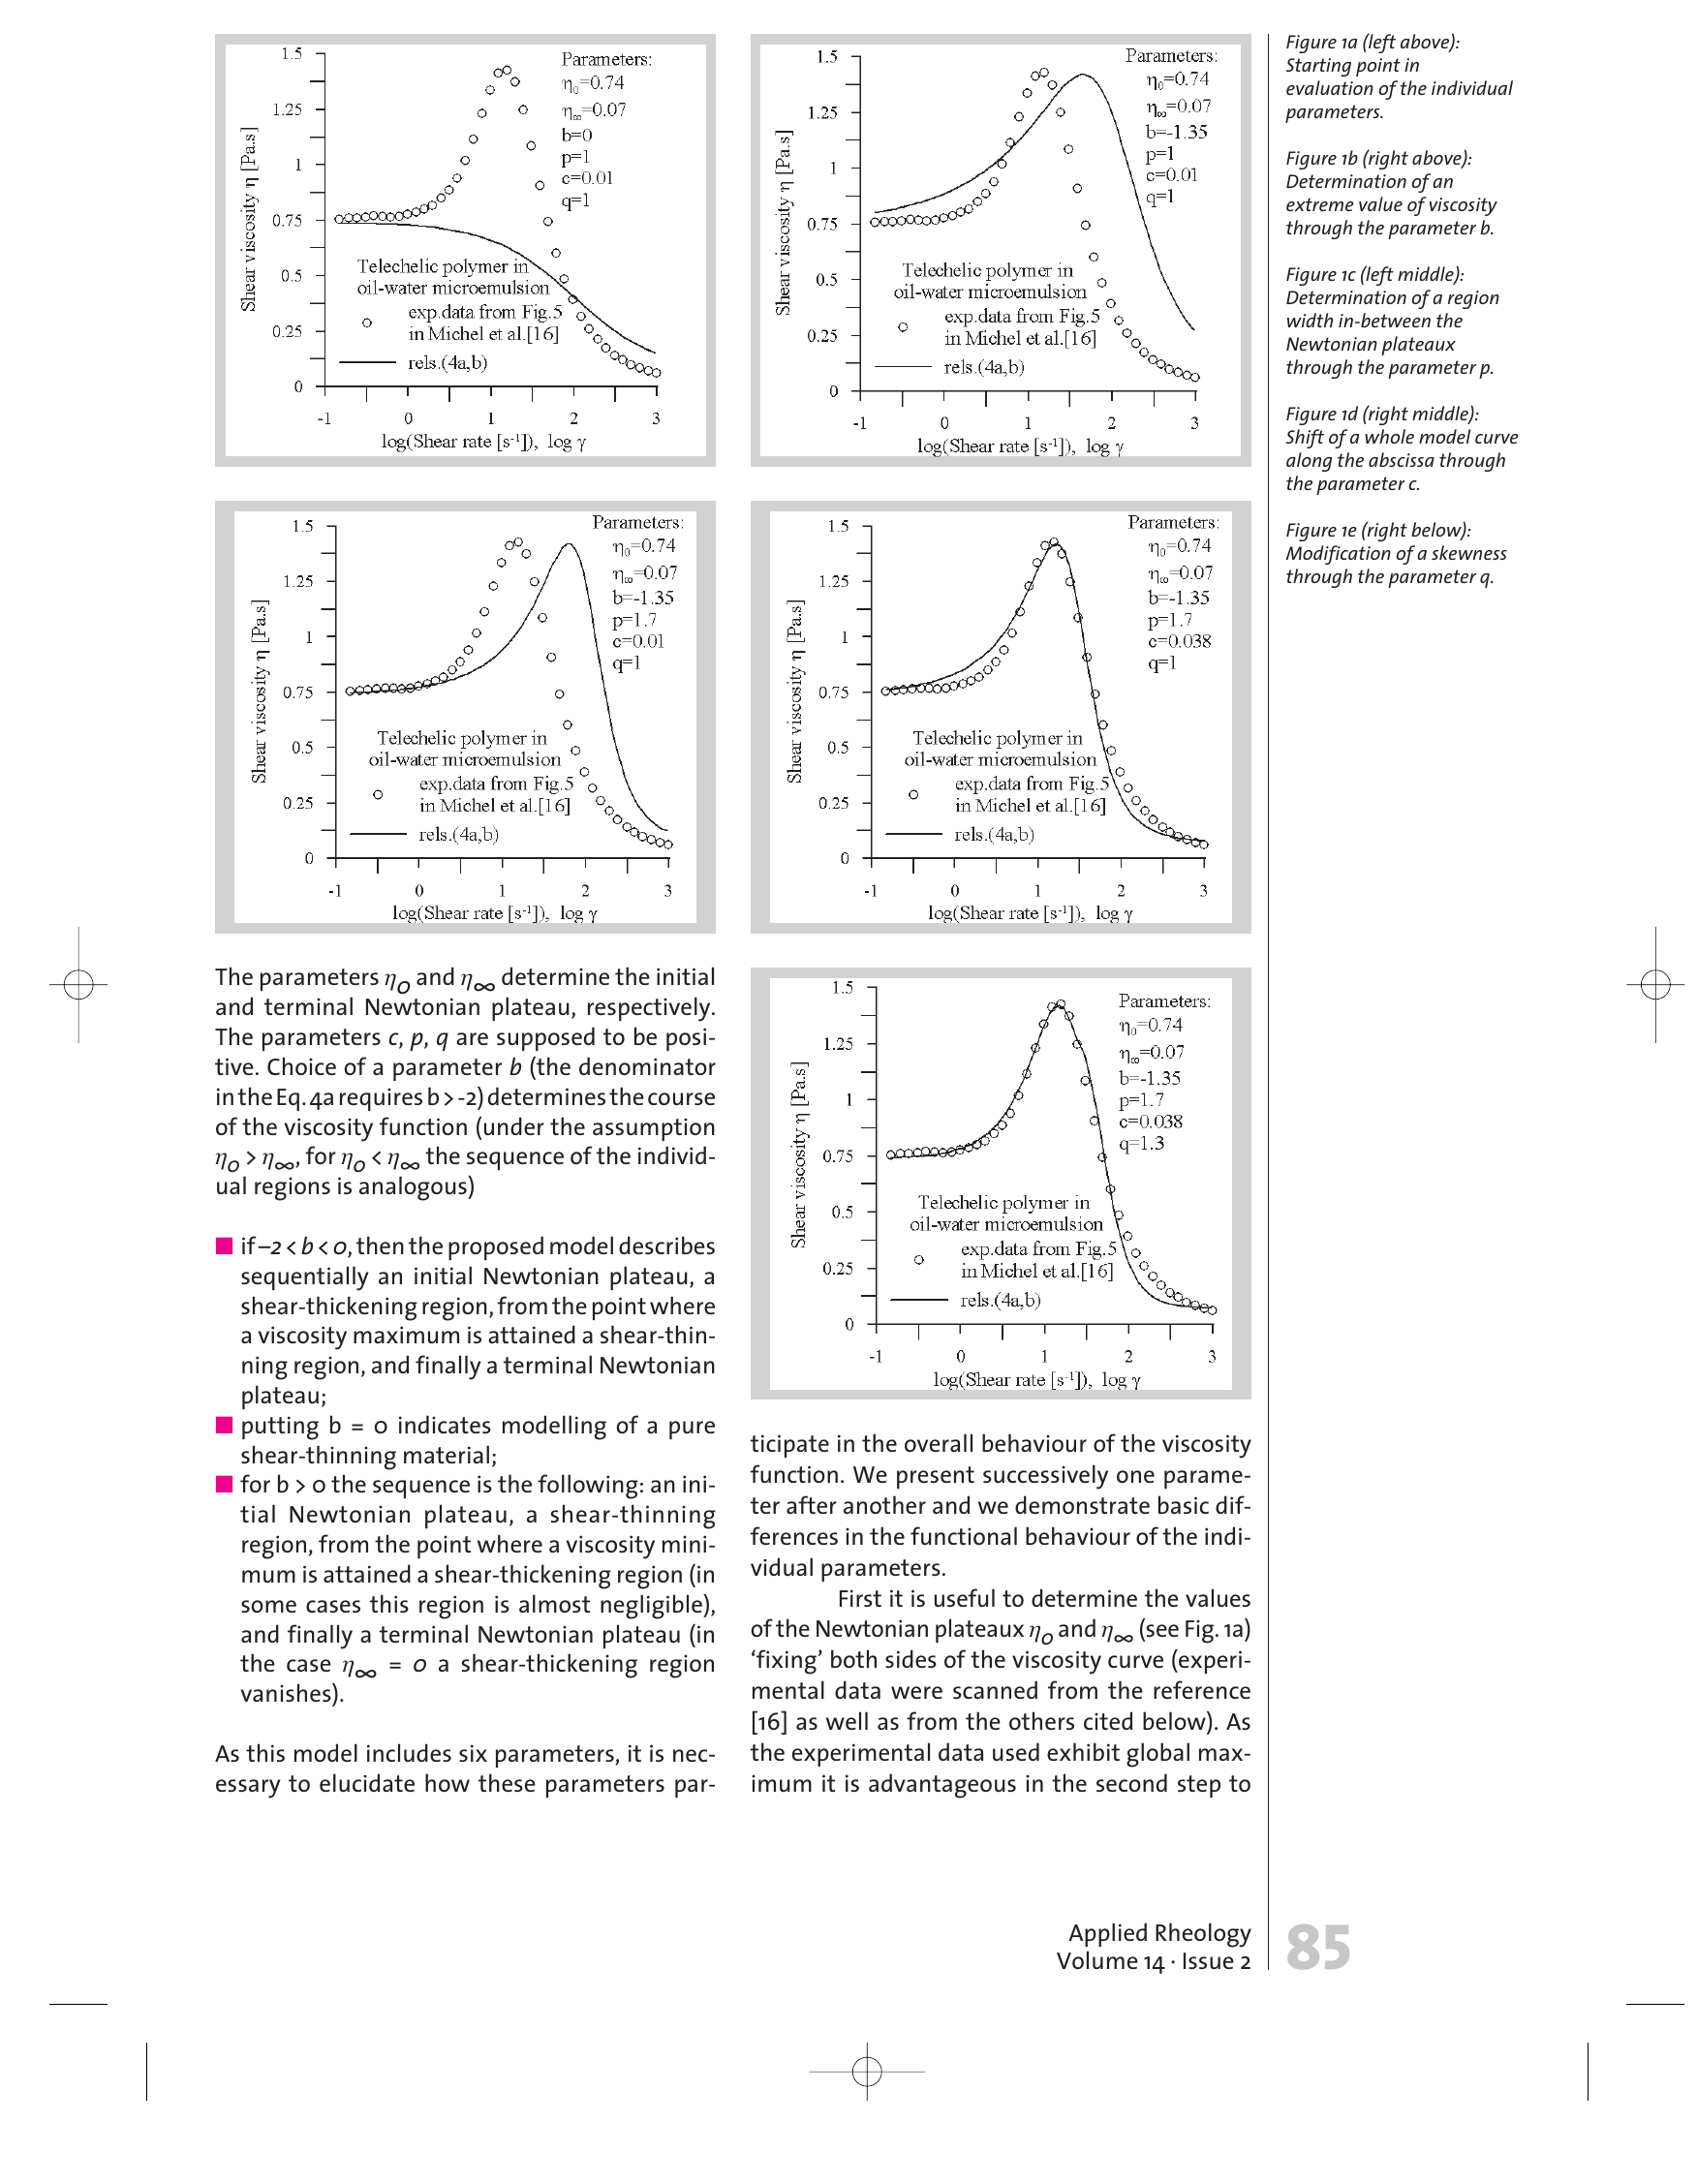
Figure 1a (left above): Starting point in evaluation of the individual parameters. Figure 1b (right above): Determination of an extreme value of viscosity through the parameter b. Figure 1c (left middle): Determination of a region width in-between the Newtonian plateaux through the parameter p. Figure 1d (right middle): Shift of a whole model curve along the abscissa through the parameter c. Figure 1e (right below): Modification of a skewness through the parameter